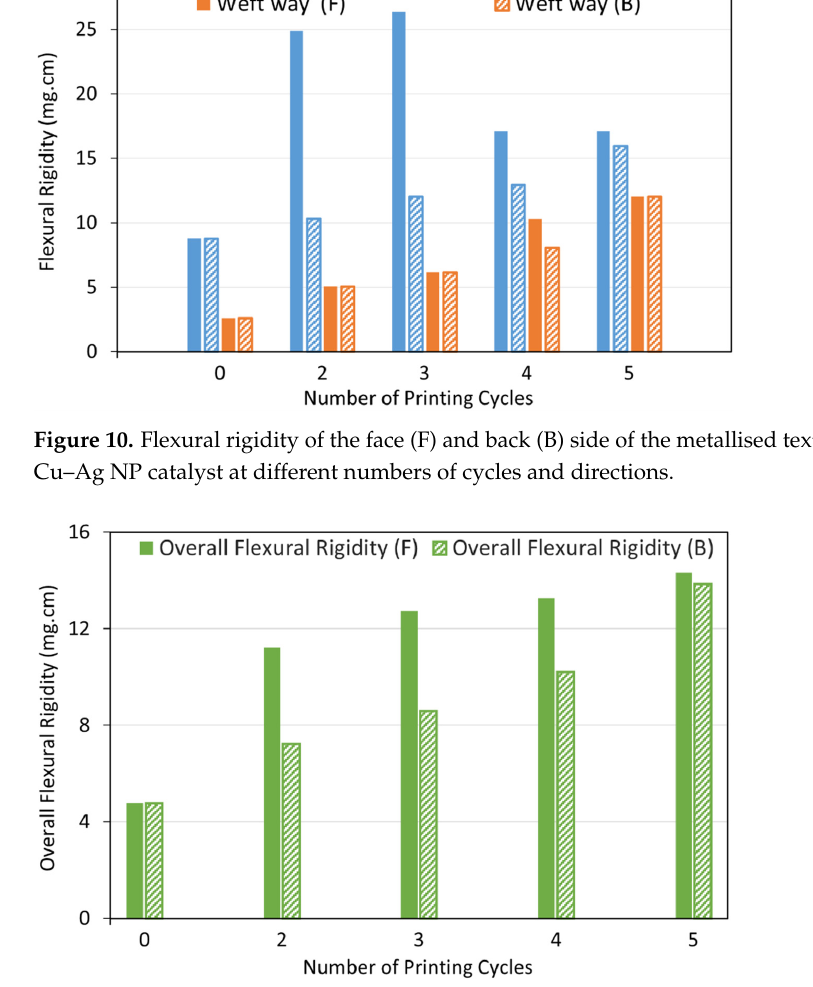
Figure 12. Photograph images of the back side of the metallised textiles printed with the Cu–Ag NP catalyst at different numbers of cycles (From left to right: untreated textile, 2, 3, 4 and 5 printing cycles) in the ( a ) warp; and ( b ) weft directions. 3.3.2. Laundering Durability and Fastness Test (Launder Ometer Test) The metallised textiles printed with the Cu–Ag NP catalyst at different conditions were washed at different numbers of cycles. After each washing cycle, the electrical re- sistance on the face and back side of the metallised samples were measured using a mul- timeter. The aim was to observe the changes in their electrical resistance as well as the colour fastness to washing following each washing cycle. The results are shown in Figure 13 and Figure 14 for the metallised samples printed with the Cu–Ag NP catalyst in the warp and weft directions, respectively. Figure 13 indicates that the resistance values of the metallised patterns printed with the catalyst in the warp direction increased signifi- cantly with increasing the number of washing cycles, at different numbers of printing cy- cles. The same trend was also observed for the metallised samples printed with the cata- lyst in the weft direction (Figure 14). As Figure 13 shows, the resistance of the metallised textile printed with the catalyst at two cycles in the warp direction increased significantly at the face side of the fabric from 1.3 Ω to 8.3 Ω after one washing cycle. After that, the sample became non-conductive. The metallised sample printed at three cycles became non-conductive after three washing cycles, while the one printed at four cycles became non-conductive after four washing cycles. After the initial washing cycles, the resistance values increased moderately due to the removal of the unfixed copper particles from the